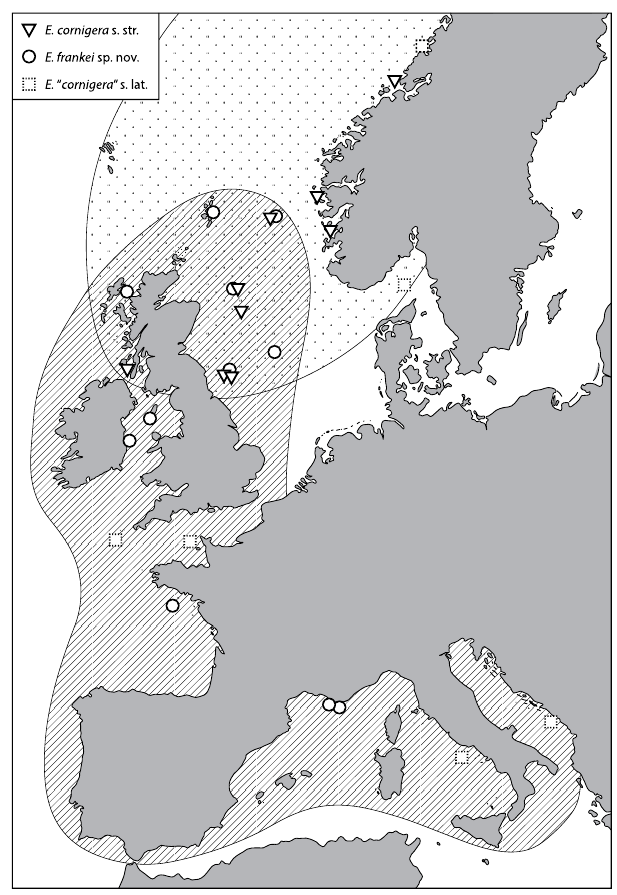
Figure 7. Suggested geographic distributions of E . cornigera and E . frankei sp. nov. considering the examined material of the current study and previous records of “ Epimeria cornigera s. lat.” (i.e. published records of “ E . cornigera ” that cannot be assigned clearly) in the literature 56,109,110,114,120–123 . Initial map built with